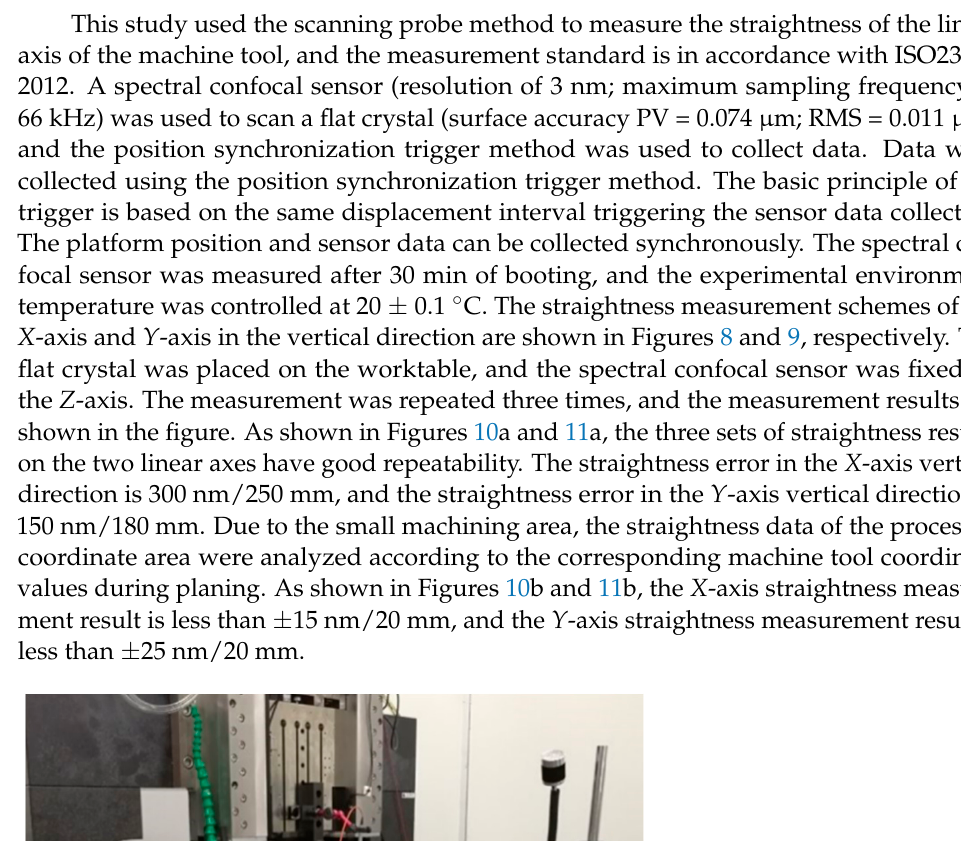
Figure 9. Straightness measurement in Y -axis vertical direction. ( a ) ( b ) Figure 10. ( a ) Straightness error in the X -axis vertical direction. ( b ) Straightness error of machining position in X -axis vertical direction. -150